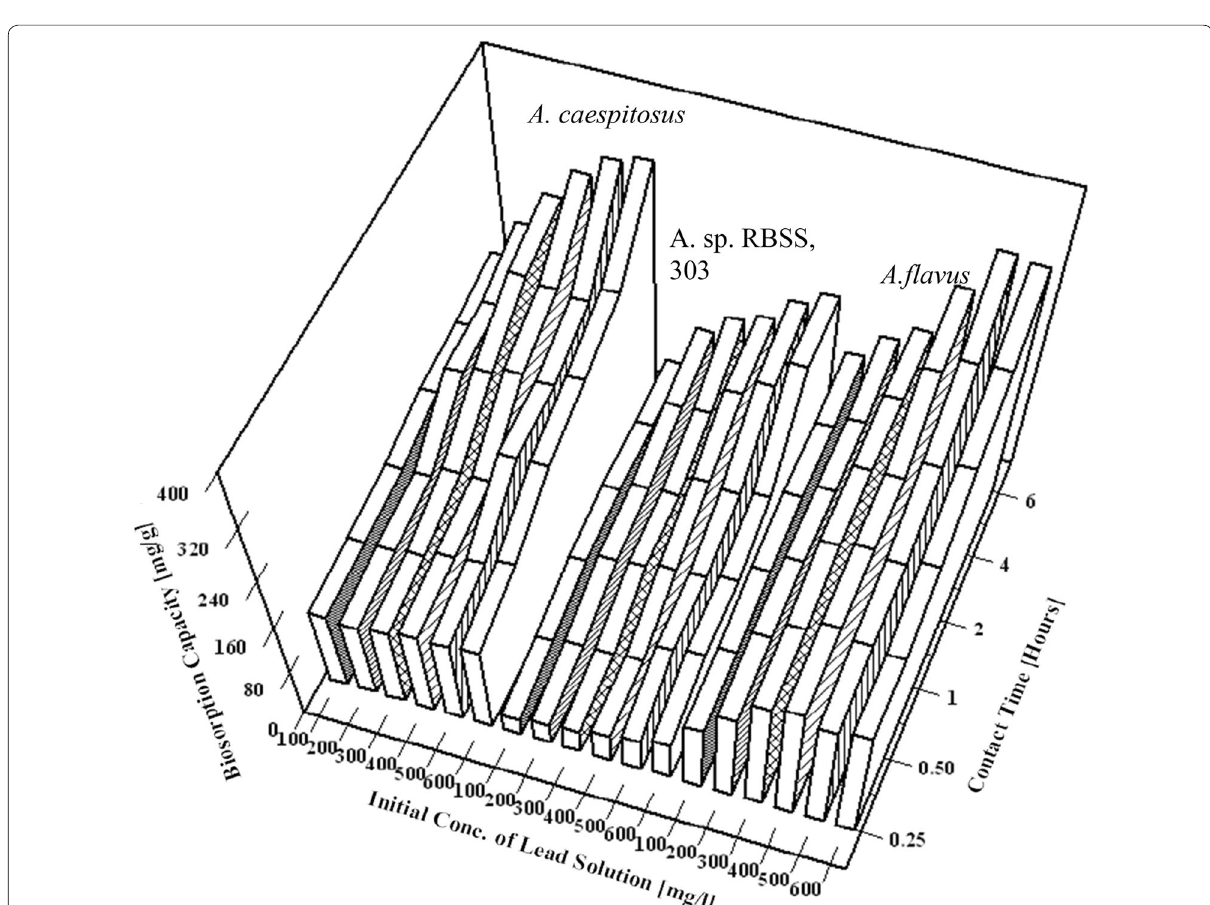
Fig. 3 Time course studies on effect of initial Pb(II) concentrations on biosorption by A. caespitosus , A. sp. RBSS.303 and A. flavus HF5 (W V 100 mL, agitation rate =